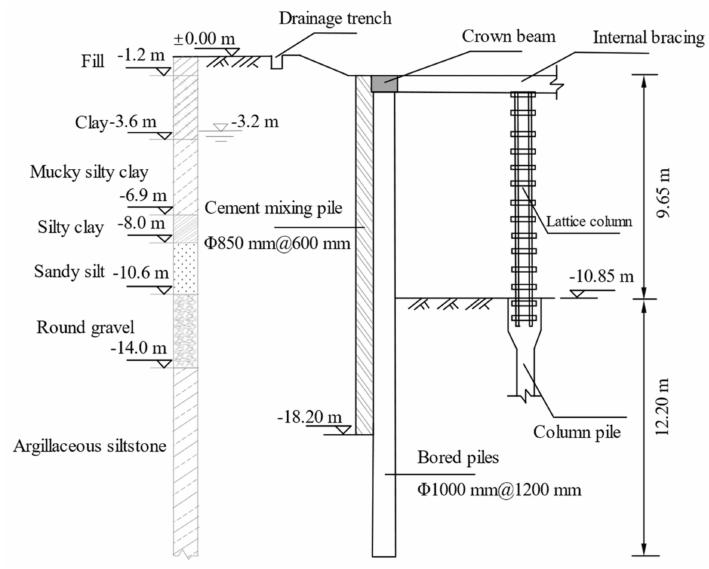
Figure 2. Schematic diagram of the profile of area B04 support